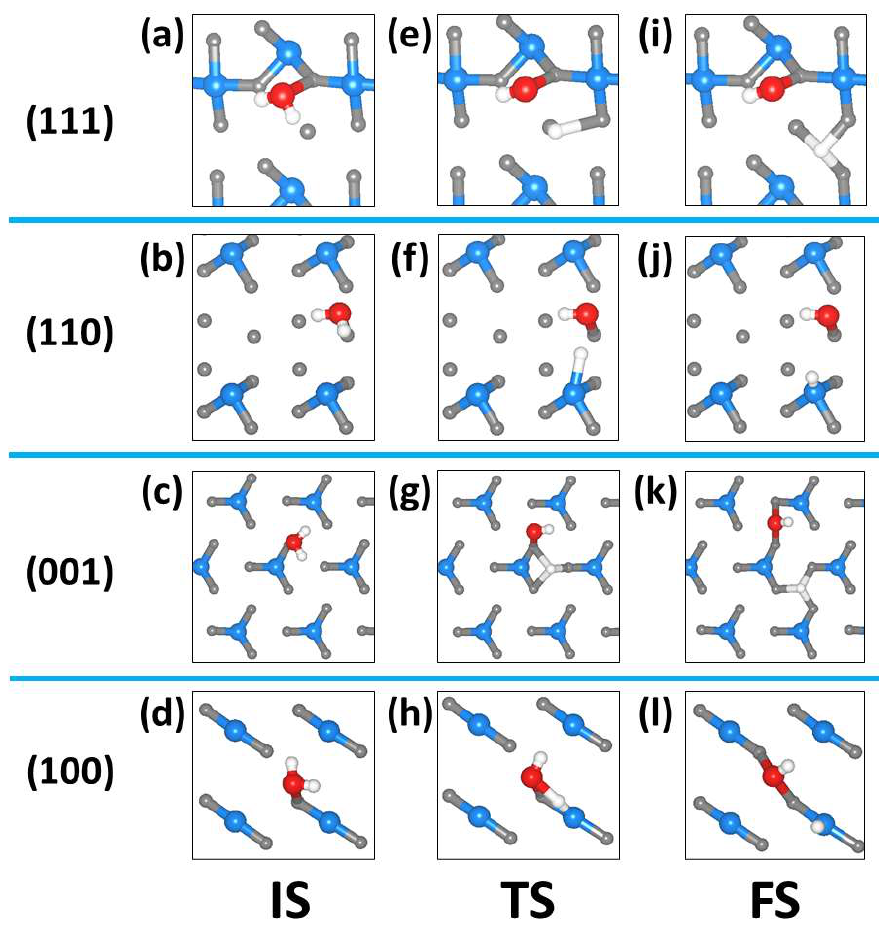
Figure 4. Overall water splitting pathways: from ( a – d ) the initial molecular water adsorption to ( e – h ) the corresponding transition state, and ( i – l ), the final H + OH co-adsorption on each of the Ni 3 N(111), (110), (001), and (100) surfaces.